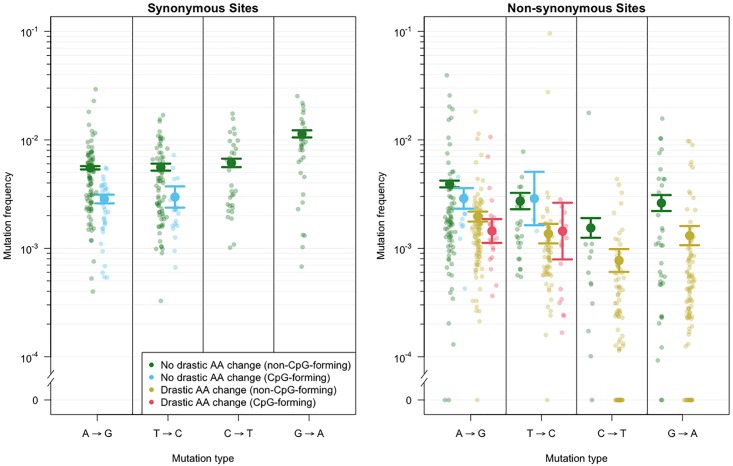
Predicted and observed mutation frequencies for different mutation classes.Mutation frequencies as predicted by the generalized linear model (large dots) and observed frequencies (small dots). The horizontal lines show the standard errors from the GLM. The graph shows the model predictions for synonymous and non-synonymous mutations that do not involve a drastic amino acid change and either form CpG sites (blue) or do not (green). In addition, for non-synonymous mutations, predictions are shown for mutations that involve a drastic amino acid change and either form CpG sites (light red) or do not (yellow).